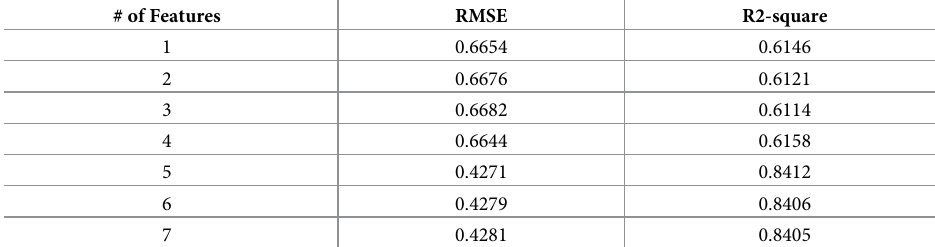
R2-score of 0.8412 and the lowest RMSE value of 0.4271 were obtained. On the other hand, with 4 features, a low R2-score of 0.6158 and a high RMSE of 0.6644 were obtained. Table 6 shows the different ratios of training and testing data samples for the best five fea- tures. The size of the testing data samples was varied from 0.1 to 0.5 of the total dataset. For each of the cases, we got R2 scores greater than 0.80. For example, at a test size of 0.3, an R2 score of 0.8412 and an RMSE of 0.4271 were obtained for the best 5 features. To show the effectiveness of linear regression, we plotted the actual values of DC biased and predicted values of DC bias for different number of features. This is shown in Fig 2. The plots are for different values of features k . We can see from Fig 2 that for the cases considered, the tested value of DC bias and the predicted value of DC bias are aligned to a good extent. So, lin- based LiFi.